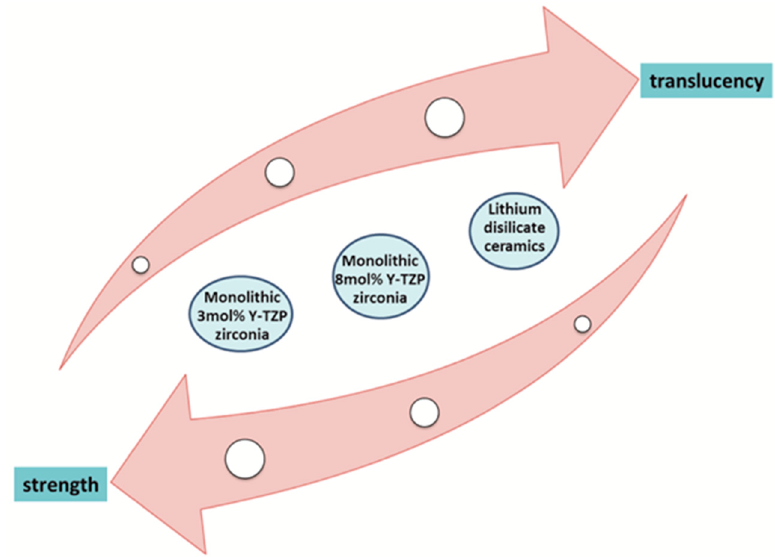
Figure 2. Figure 2. Correlation of translucency and strength of contemporary zirconia and lithium disilicate ceramics.